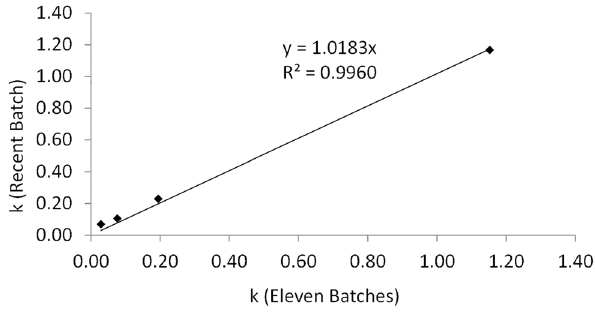
Figure 5. Comparison of the obtained and predicted k values. Observed k values obtained with stability studies of the recent batch during six months, against the k values obtained with the Arrhenius equation of the eleven batches of Bacilor H ( Lcr restituo H capsules) (the k value at 40 u C for the eleven batches was not available and was predicted with the Arrhenius equation).